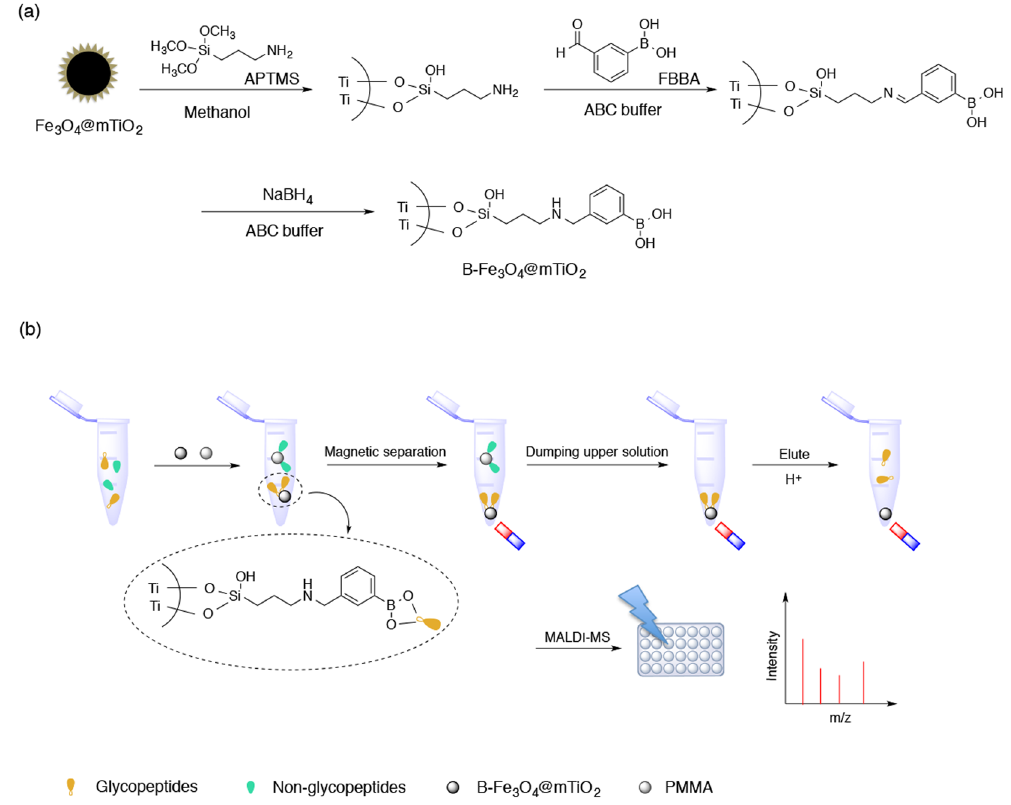
Figure 1. Graphic illustration of ( a ) the preparation steps for B-Fe 3 O 4 @mTiO 2 and ( b ) the procedure for the detection of N-glycopeptides using a combination of B-Fe 3 O 4 @mTiO 2 and